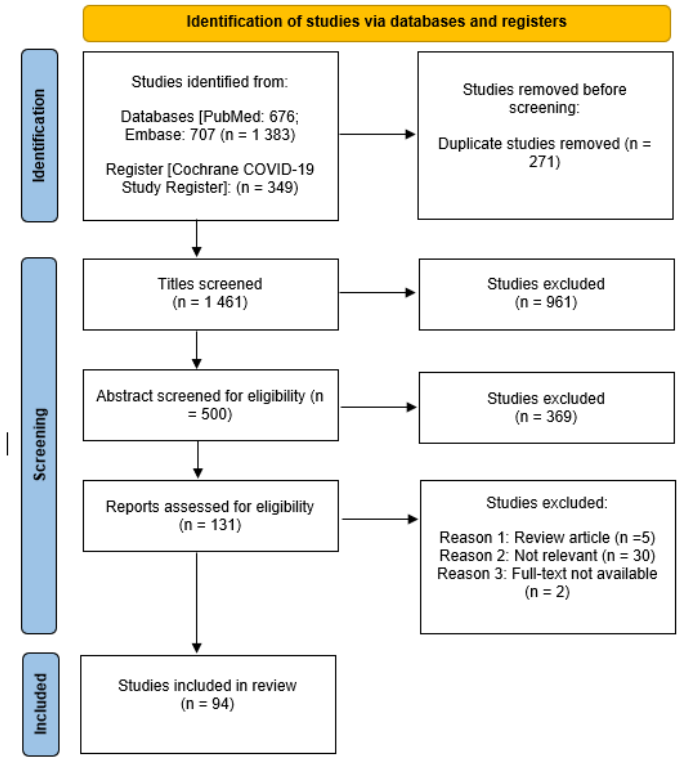
Figure 1. The preferred reporting items for a systematic review and meta-analysis (PRISMA) flow diagram.